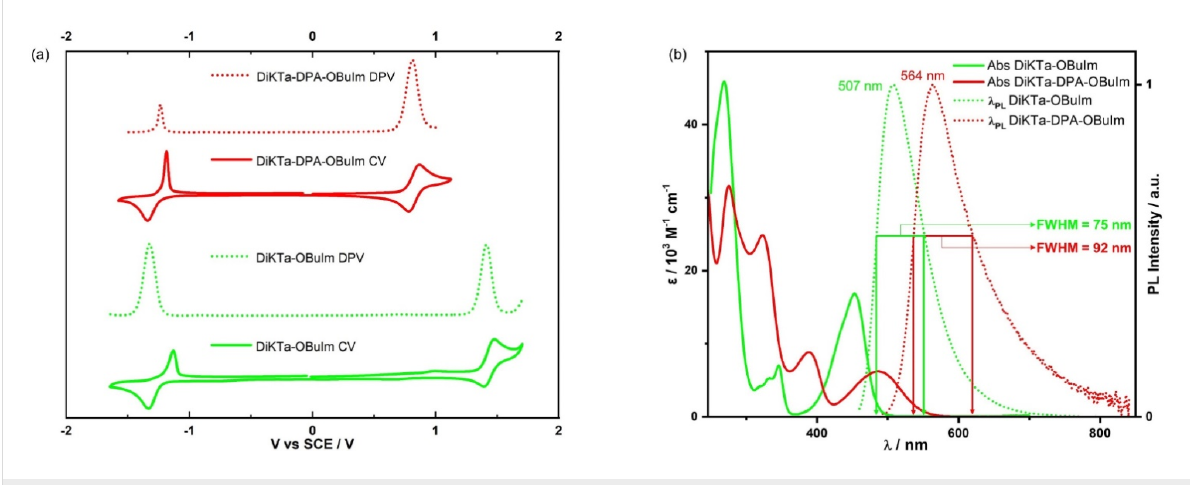
Figure 3: (a) Cyclic and differential pulse voltammograms measured in degassed MeCN with 0.1 M [ n- Bu 4 N]PF 6 as the supporting electrolyte and Fc + /Fc as the internal reference (0.38 V vs SCE) [32]. Scan rate = 100 mV s − 1 ; (b) solution-state photophysical measurements: absorption and steady-state emission spectra at 300 K measured in MeCN. λ exc = 453 nm for DiKTa-OBuIm and λ exc = 488 nm for DiKTa-DPA-OBuIm